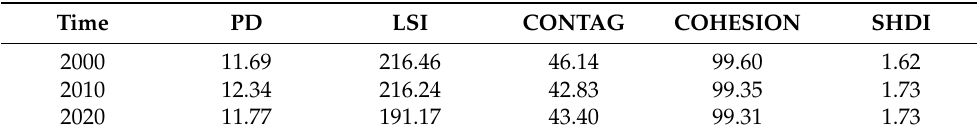
Table 8. Landscape pattern indexes for landscape scale in the study